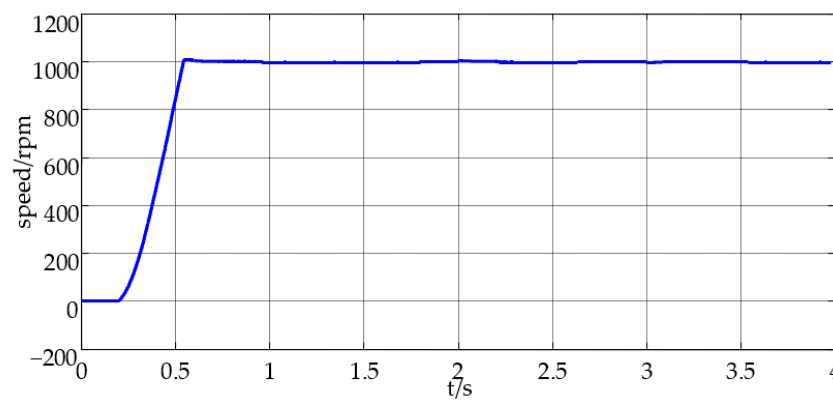
Figure 9. Dynamic speed waveform.